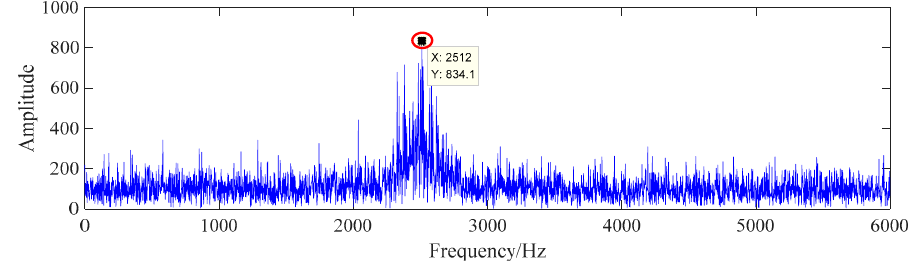
Figure 6. The frequency domain of the signal with noise.